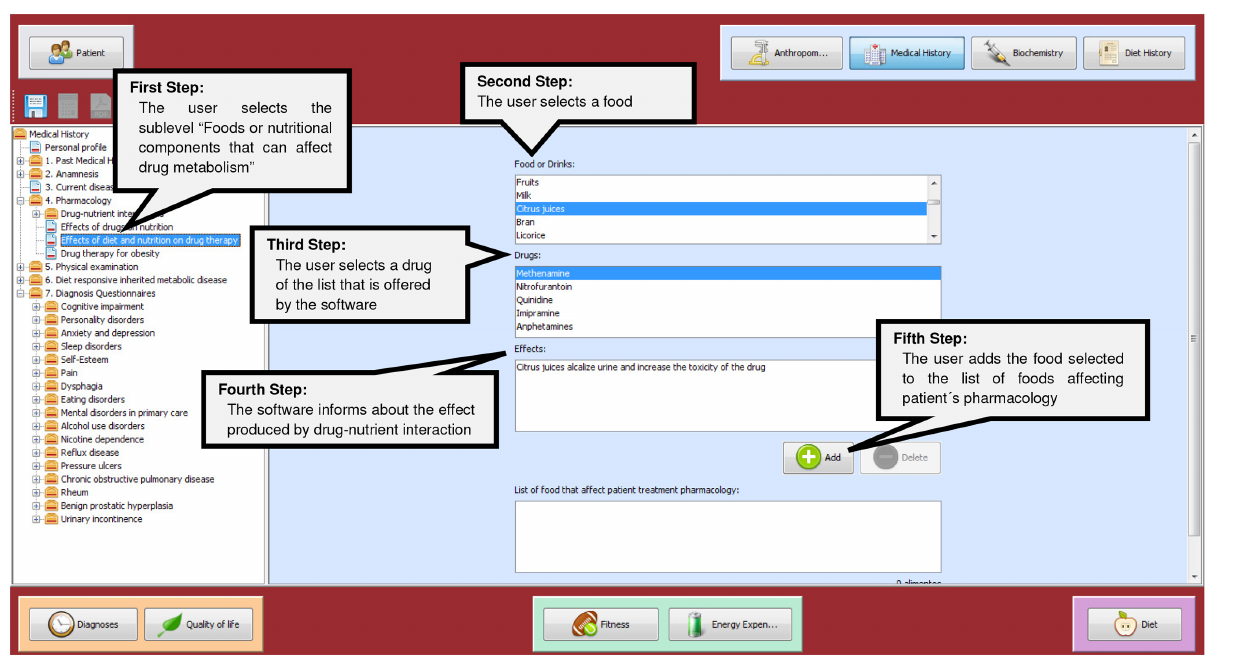
Fig 2. A screenshot of a section of the module of Medical